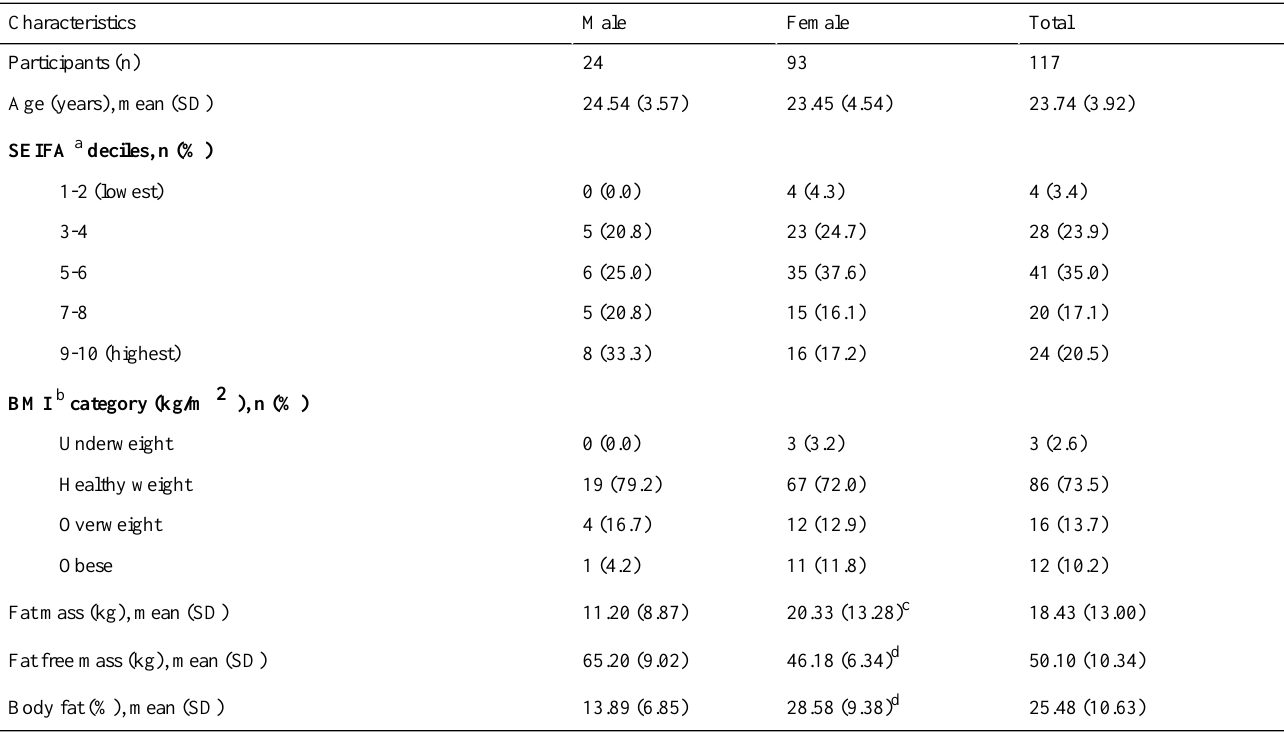
Table 1. Baseline data of adults participating in the Web-based food addiction study. TotalFemaleMaleCharacteristics 1179324Participants